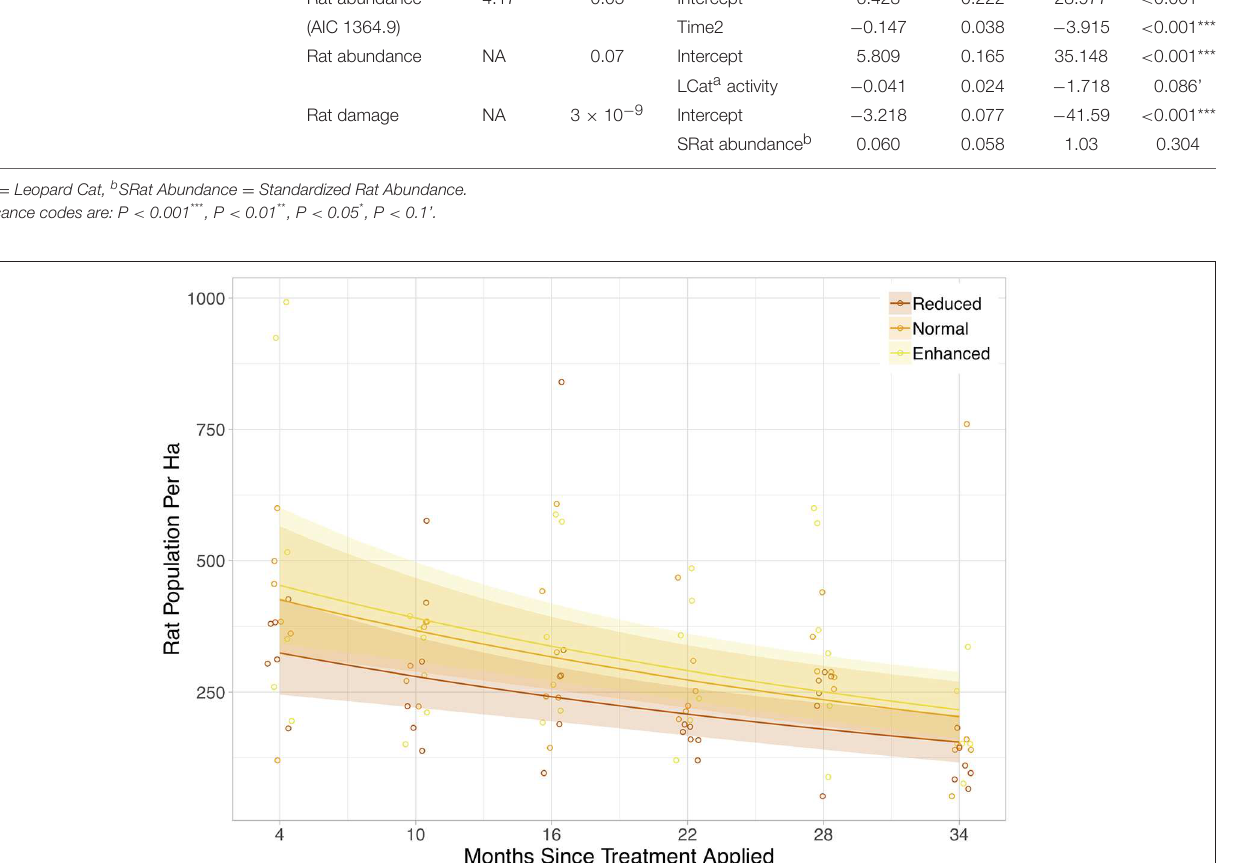
made up the vast majority of recordings, with 146 occurrences logged over the collection period. From trapping data, rat abundances were also high but very variable across our plots,